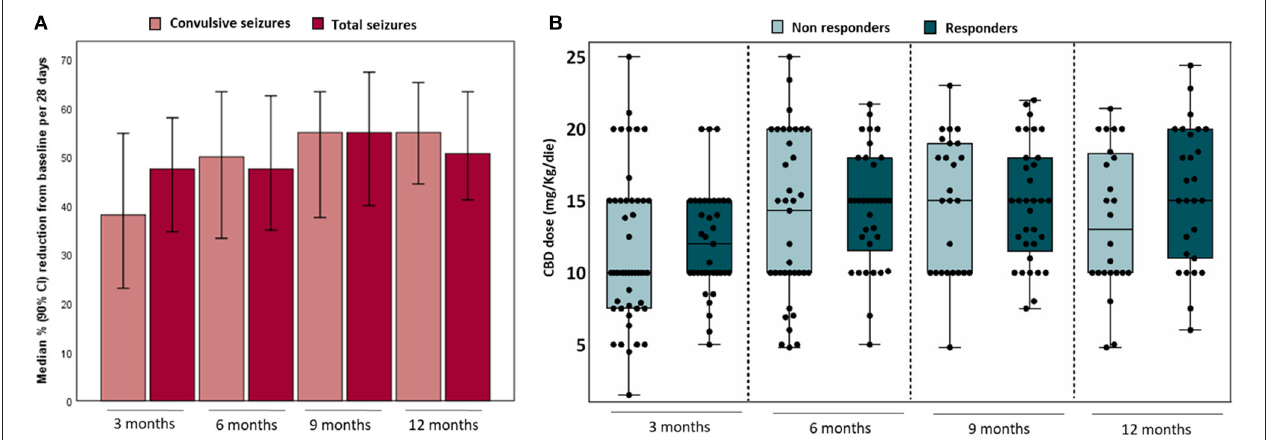
FIGURE 2 | Percentage reduction in median seizures per 28 days from baseline in convulsive and total # seizures for effectiveness analysis (A) and CBD doses related to achieving responder status at different outcomes (B) . # Total seizures included convulsive seizures (i.e., clonic, tonic, tonic–clonic, atonic, focal secondary generalized) and non-convulsive seizures (i.e., myoclonic, absence, myoclonic-absence, focal with and without impaired consciousness). NR, non-responders; R, responders ( ≥ 50% frequency reduction and seizure-free).